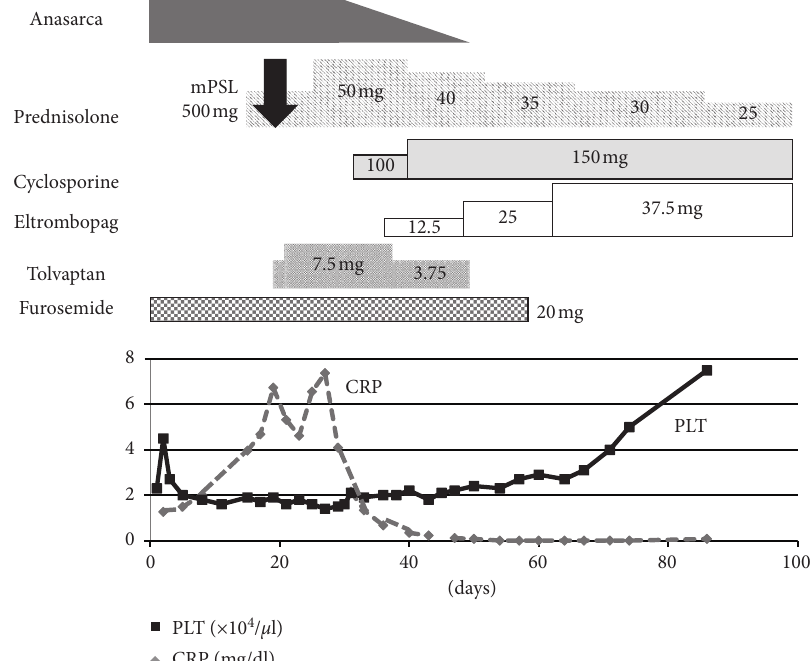
Figure 3: Clinical course of treatment and response of the patient. CRP, C-reactive protein; mPSL, methylprednisolone; PLT,